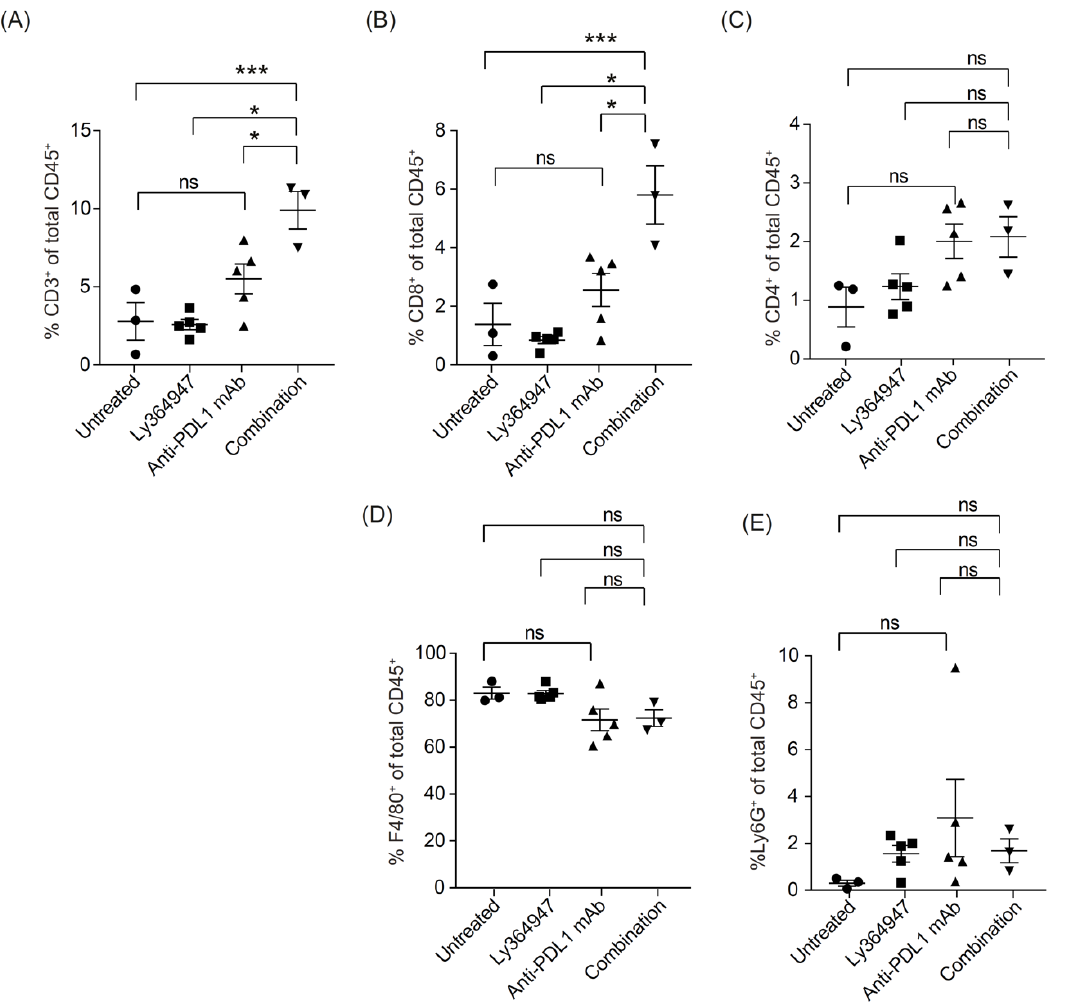
Figure 3. Combining TGF- β receptor kinase inhibitor LY364947 with anti-PDL1 mAb modulates infiltration of T cells in the tumor. Mice with established MC38 were treated with anti-PD-L1 mAb (200 µ g; days 8, 10, and 13) and / or LY364947 (10 mg / kg; days 8, 10, 13, and 14). Tumors were harvested at day 15 and analyzed for the percentages of CD3 ( A ), CD8 ( B ), CD4 ( C ) T lymphocytes, ( D ) F4 / 80 + macrophages, and Ly6G + granulocytes ( E ) by flow cytometry. Bars represent mean ± SEM. Statistical significance was determined by one-way ANOVA (* p < 0.05; *** p < 0.001; ns, non significant).